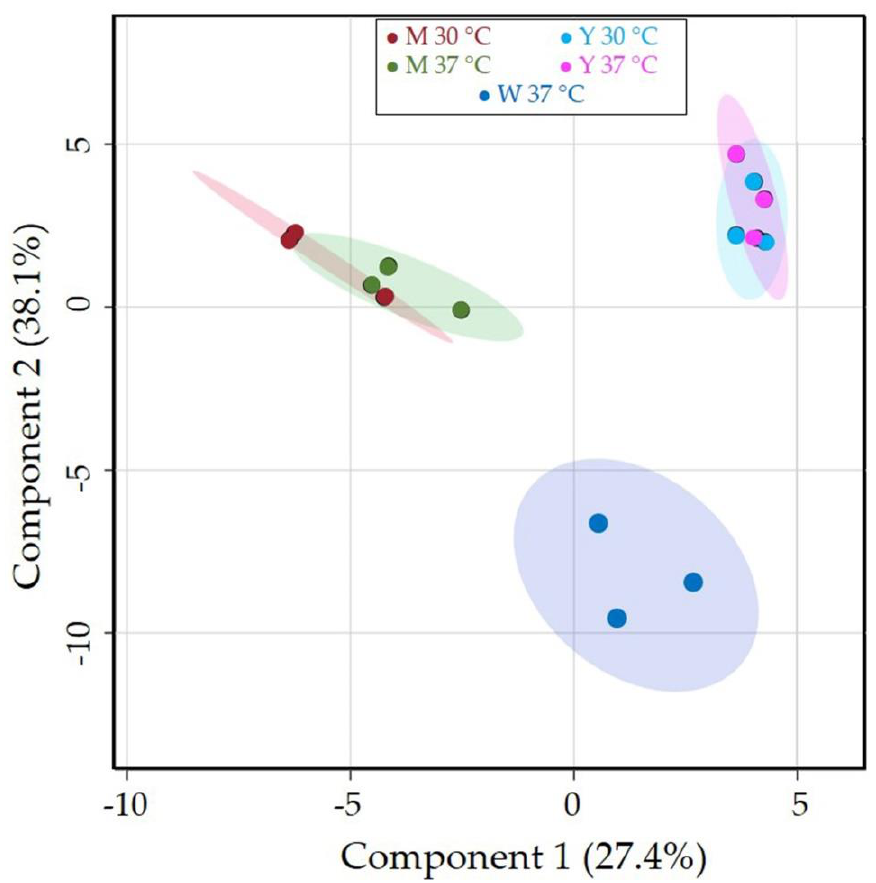
Figure 2. Partial least squares — discriminant analysis score plot of intracellular metabolomes ob- tained from C. albicans at 37 °C in water (W, blue circles) and at 30 °C and 37 °C in YPD (Y, cyan and magenta circles) and M199 (M, red and green circles) media. Colored ellipses represent the 95% confidence regions of each clustering.